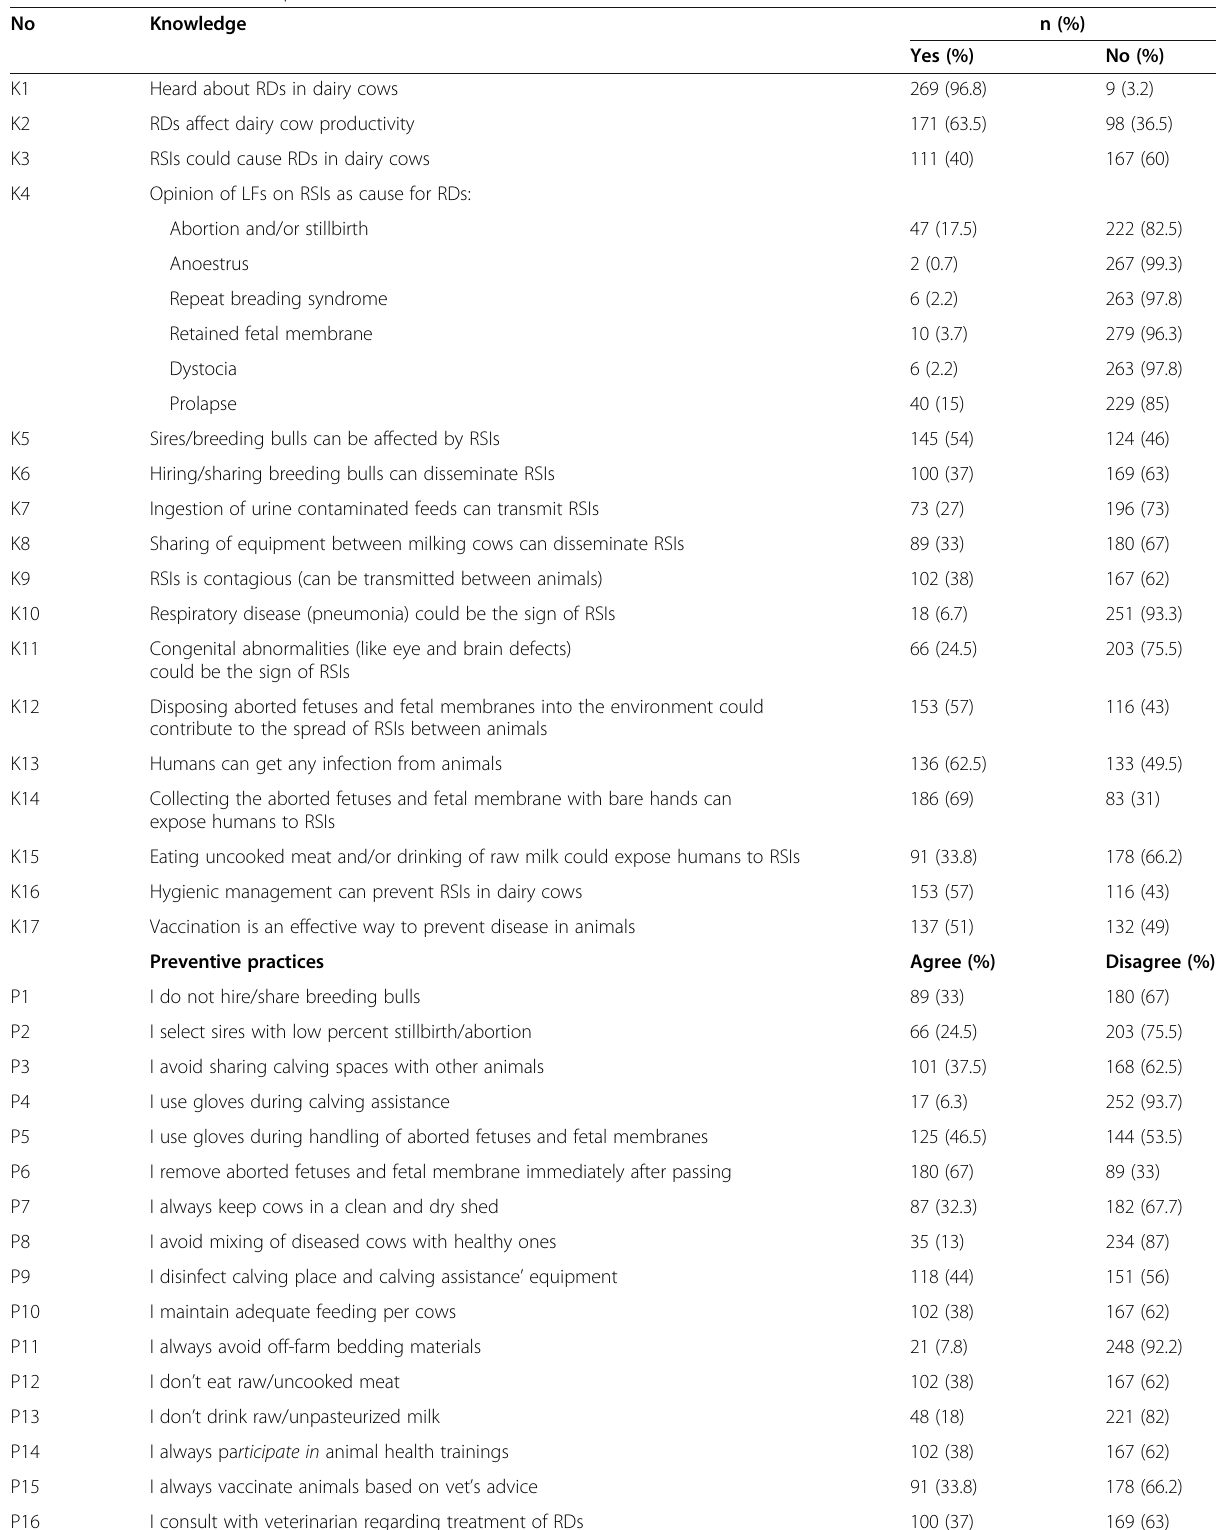
Table 2 Knowledge and preventive practices of LFs on infectious causes of reproductive disorders in dairy cows in the Kembata Tambaro zone, southern Ethiopia ( n = 278